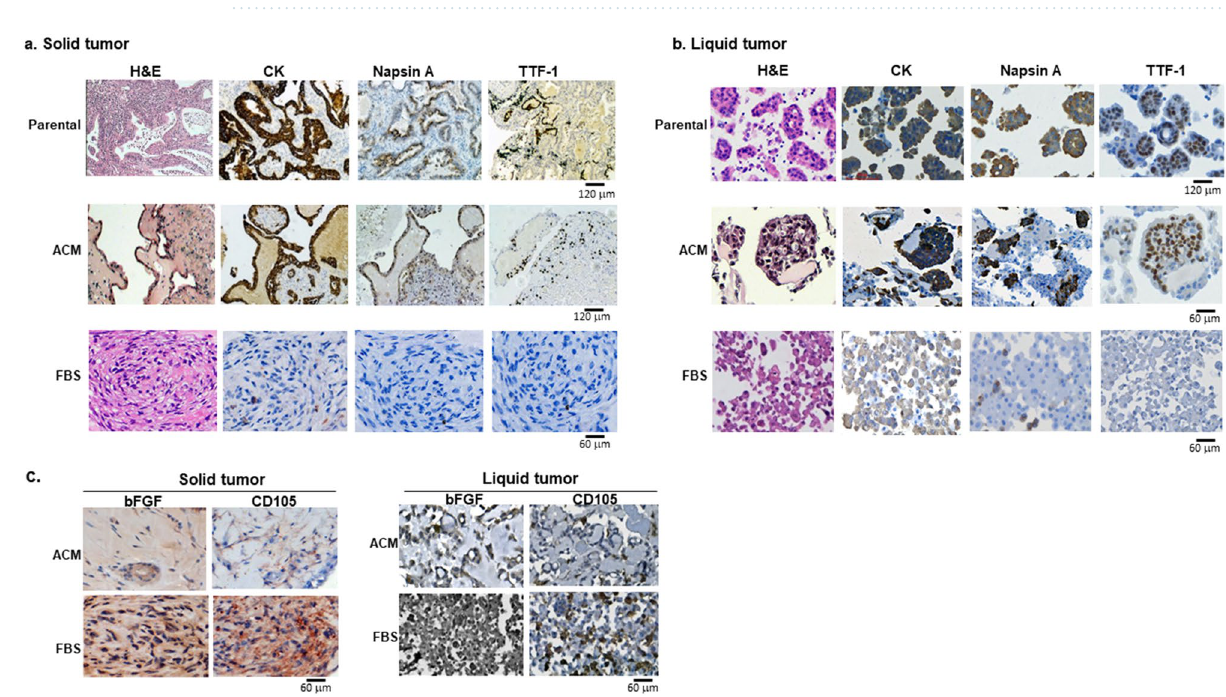
Figure 3. The similarity in immune phenotypes of ACM-cultured tissues to parental cancers. H&E and IHC stains of lung adenocarcinomas. ( a ) Solid tumor; ( b ) Pleural effusion sample. Parental tumors (top row; scale bar = 120 µm), ACM-cultured (middle row; scale bar for solid tumors is 120 µm, and for body fluid samples is 60 µm) and FBS-cultured (bottom row; scale bar = 60 µm). Antibodies: CK (cytokeratin), Napsin A and TTF-1. ( c ) IHC for FGF and CD105 expressions in above cultures (scale bar = 60